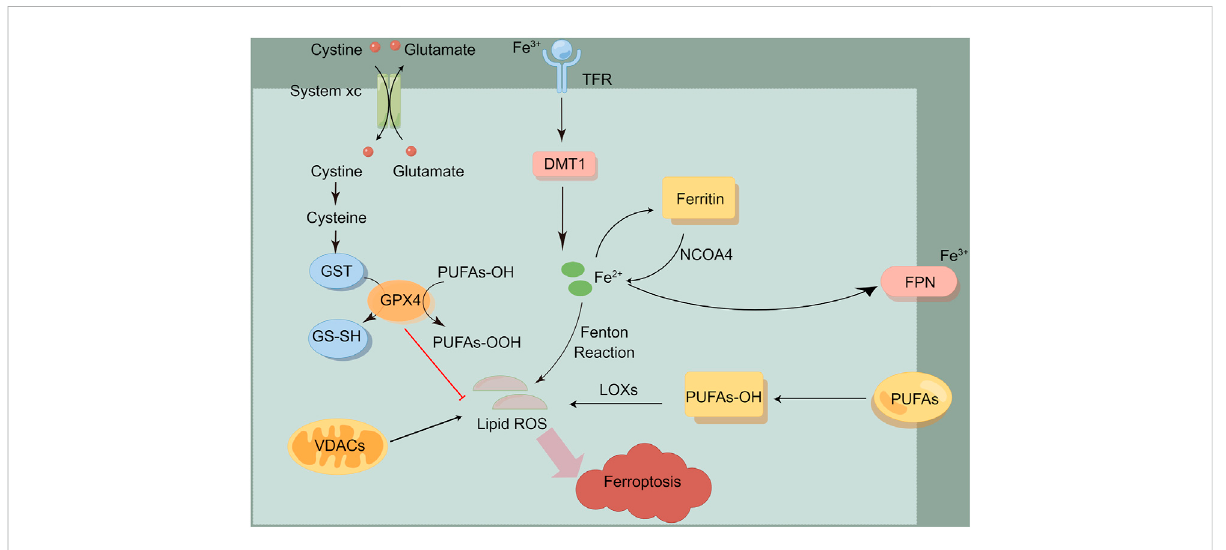
The overview of ferroptosis. Ferroptosis is mainly induced by iron metabolism, lipid metabolism, amino acid metabolism and other processes. This fi gure was drawn by